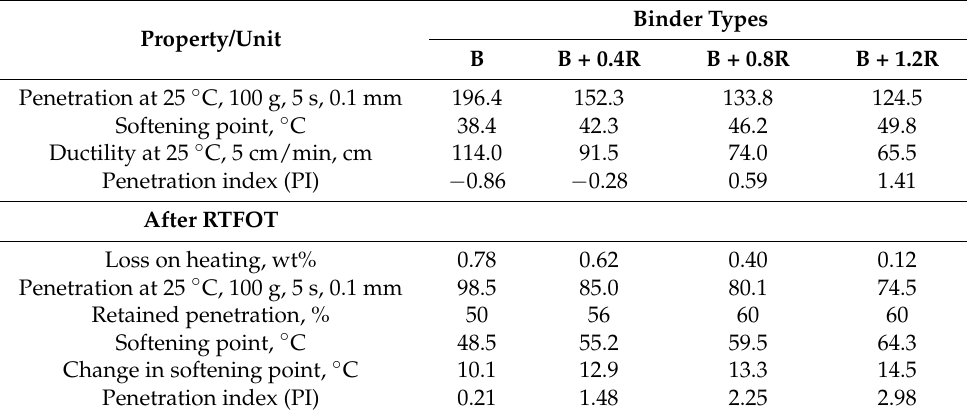
Table 4. The physical properties of binders before and after RTFOT process.